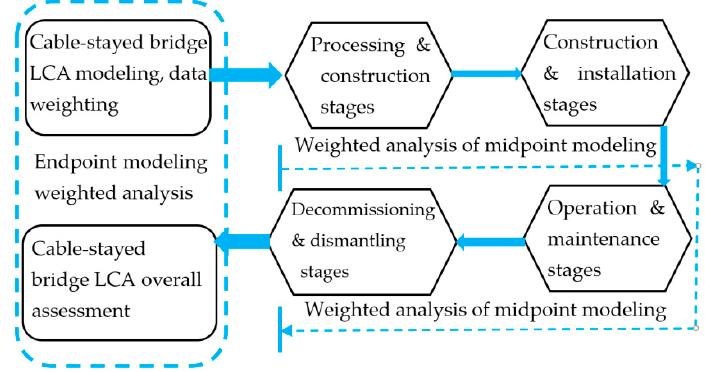
Figure 3. Schematic diagram of cable-stayed bridge modeling process.